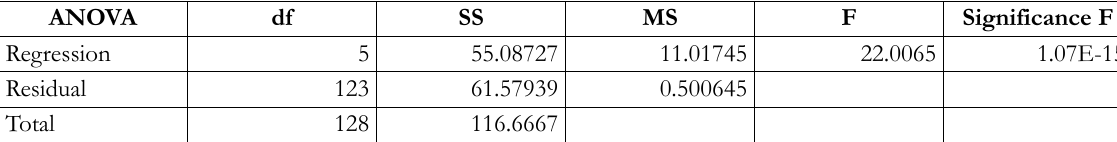
Table 12. Analysis Output of Sensitizations and Training against Increased usage of ICTs Hypotheses: